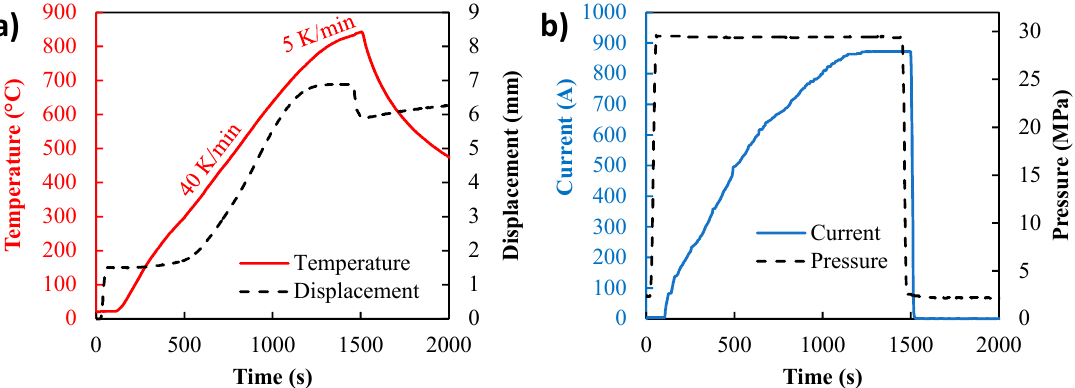
Figure 3. Obtained experimental data from the spark plasma sintering experiment with ( a ) temperature and displacement, ( b ) pressure and electric